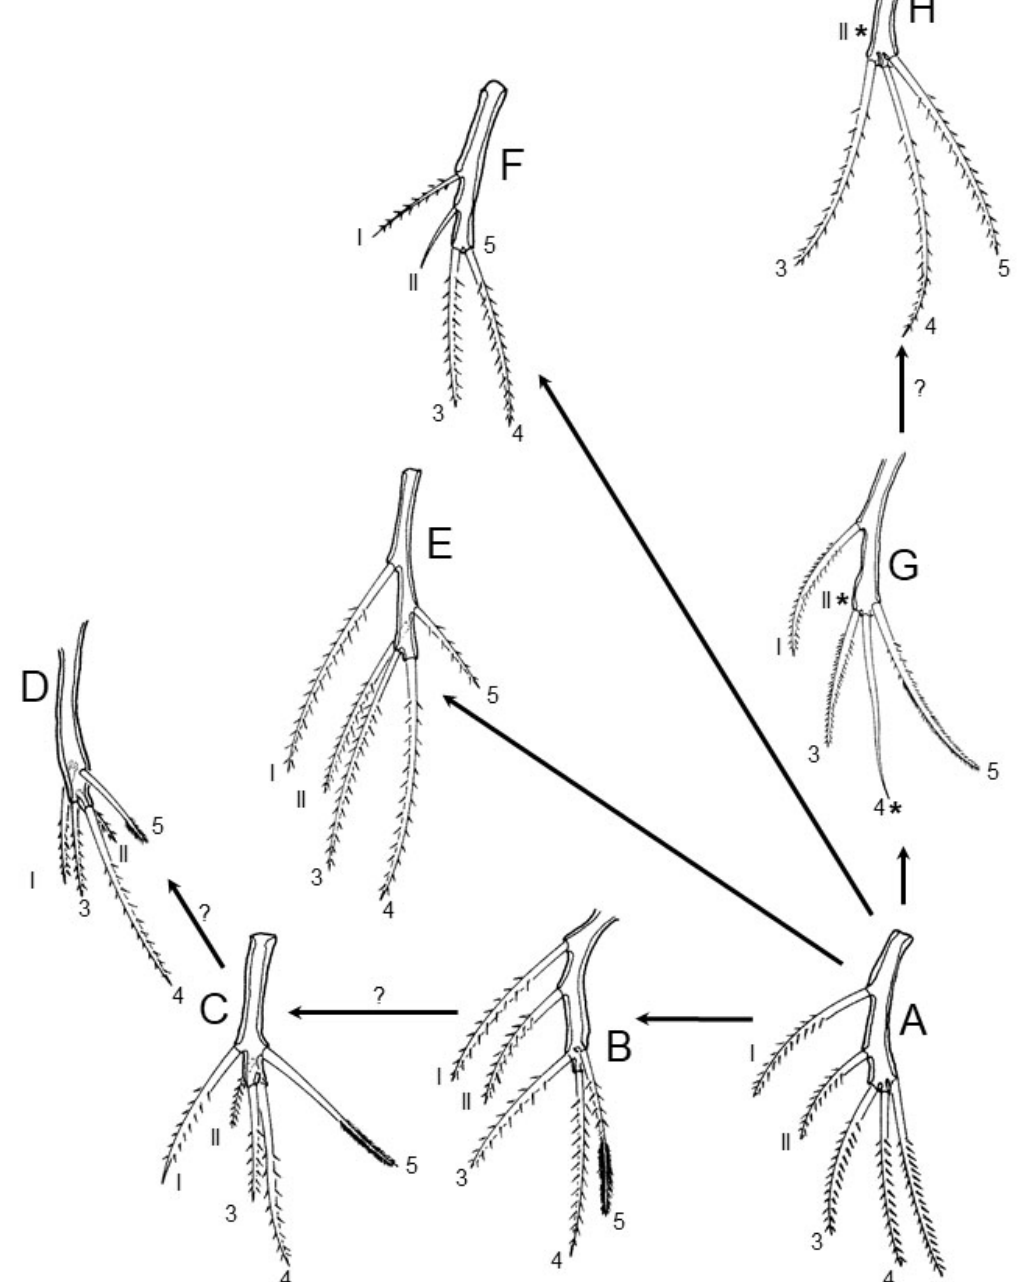
Fig. 18. Schemes of the female P5 exopod(al lobe). A . Paratouphapleura gen. nov., Pseudechinopsyllus